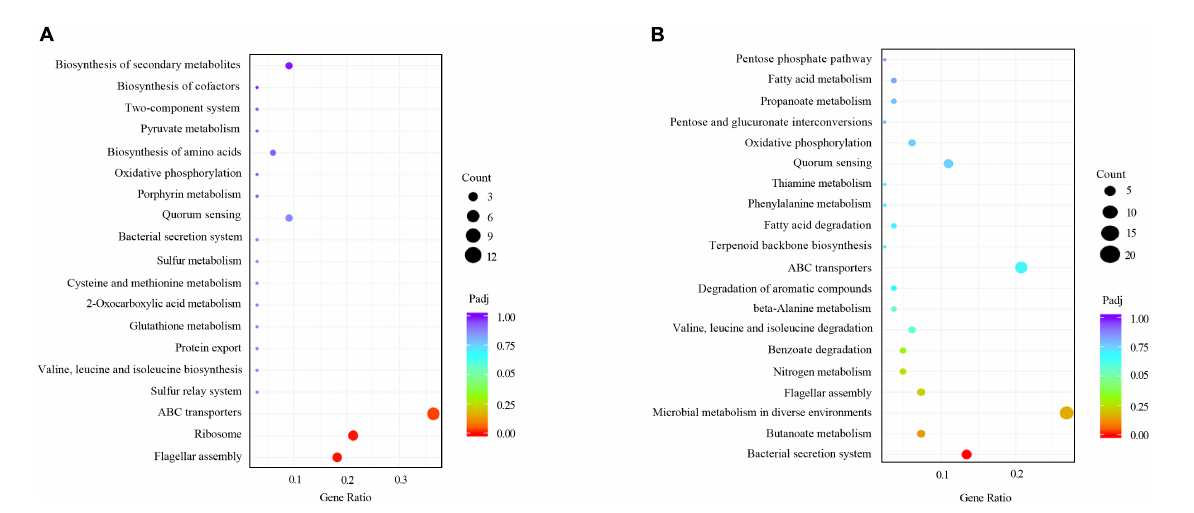
FIGURE4 KEGG analyses of the differentially expressed genes (DEGs) between the B. melitensis 16M biofilm under 1.5 M NaCl and control conditions. The rich factor represents the ratio of (A) upregulated genes and (B) downregulated genes differentially expressed gene numbers annotated in this pathway term to all gene numbers annotated with this pathway term. A greater rich factor indicates a greater degree of pathway enrichment. The padj represents the corrected P -value and ranges from 0 to 1, and a lower value indicates greater pathway enrichment.